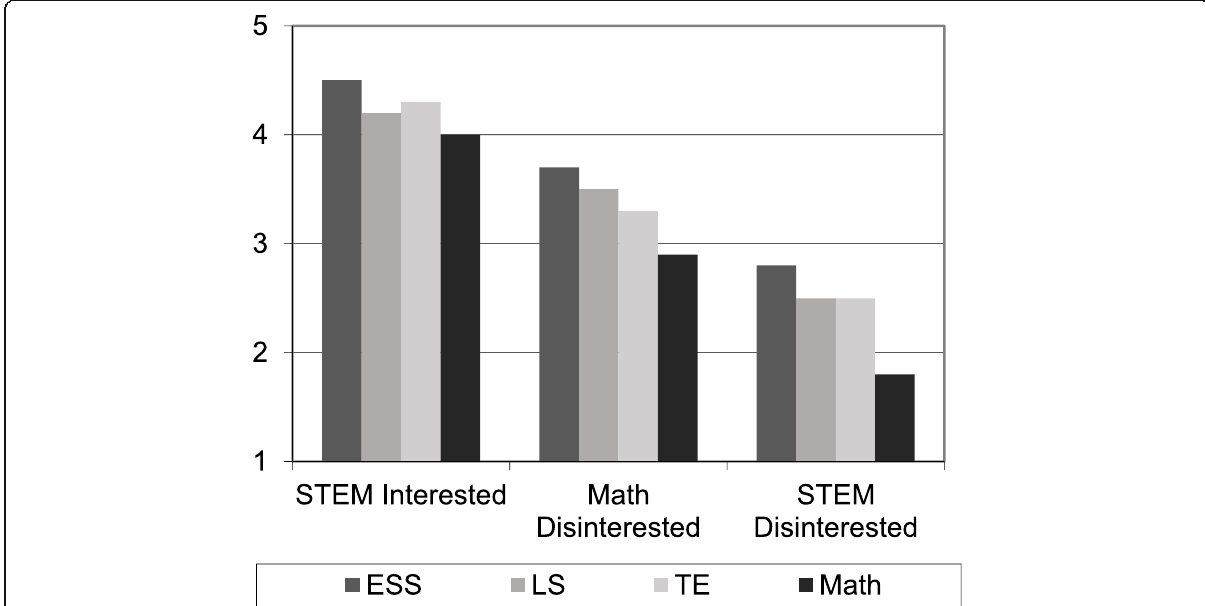
Fig. 2 Interest scores for the four STEM components across the three STEM interest profiles for youth aged 12/13 (seventh grade). ESS = Earth/ space science; LS = Life science; TE = Technology/engineering. Interest scores ranged from 1 = “ Not interested ” to 5 = “ Very interested